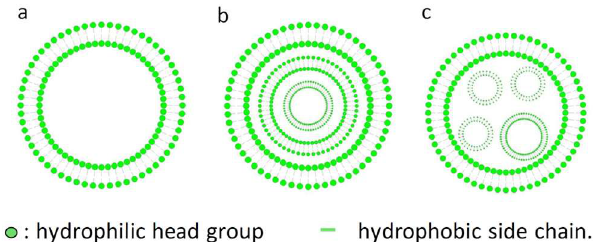
Figure 1. Schematic structures of non-ionic surfactant vesicle. ( a ) unilamellar vesicle, ( b , c ). multi-lamellar vesicle.